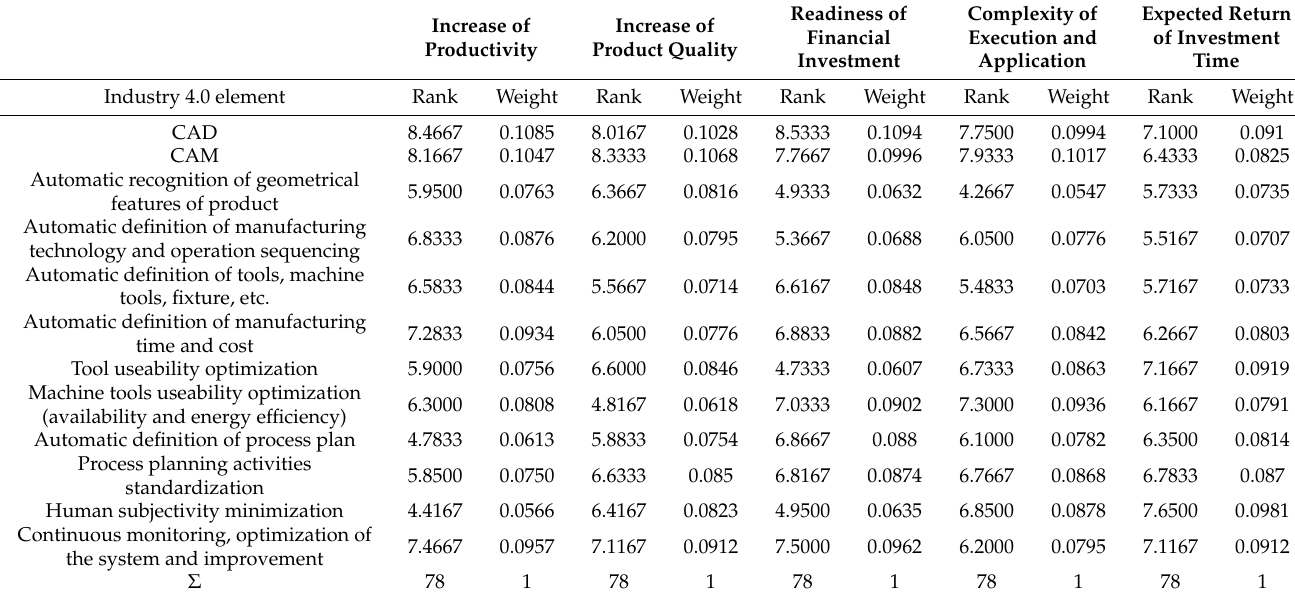
Table 4. Ranks of the elements from the “smart process planning” group.